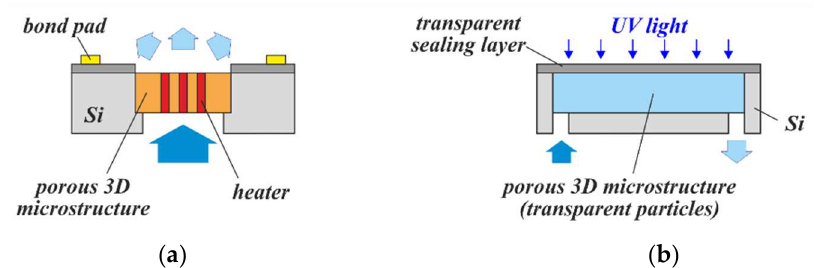
Figure 20. Concepts for PowderMEMS gas sensors: ( a ) Resistive heating of the catalyst. ( b ) Optical activation of the catalyst. activation of the catalyst.